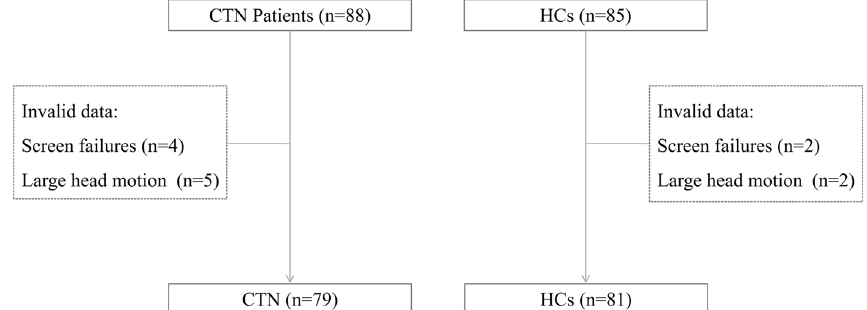
Fig. 1 Selecion of patients with CTN and HCs. CTN, classical trigeminal neuralgia; HCs, healthy